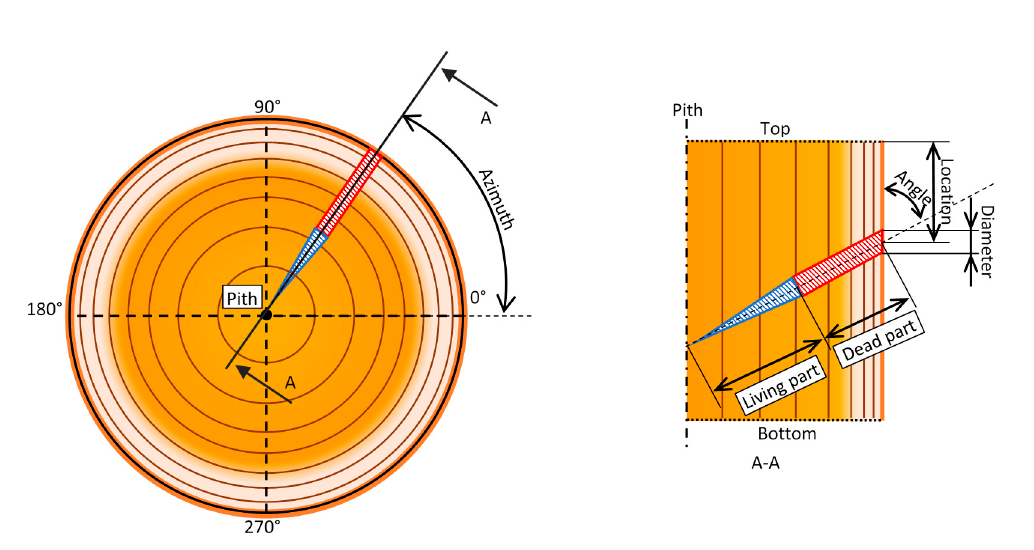
Figure 4. Schematic of selected branch criteria.